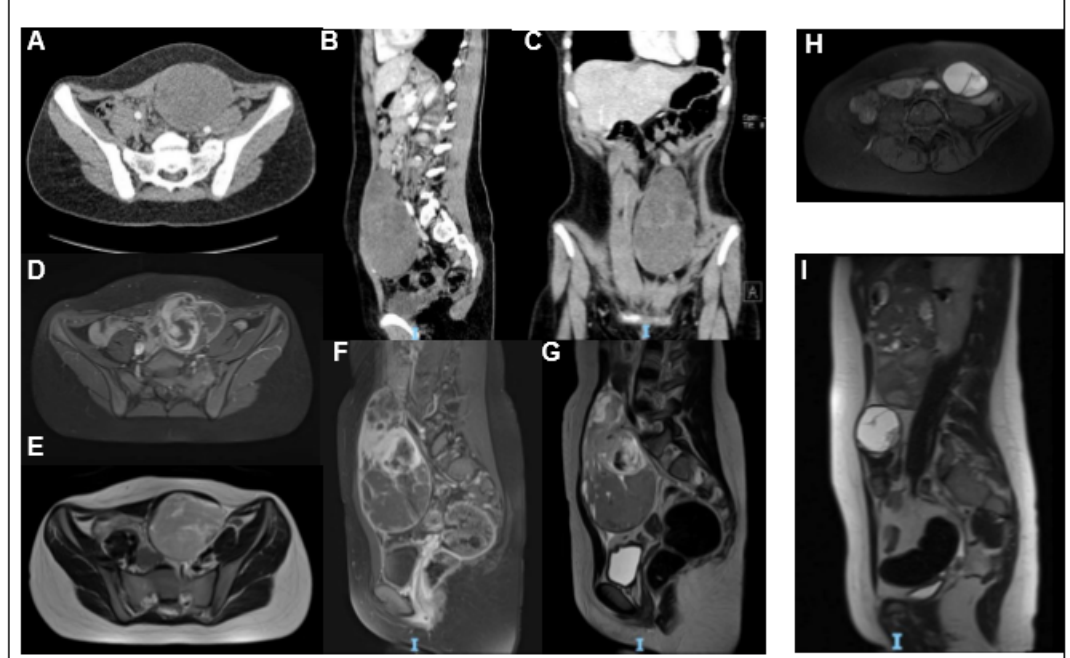
Figure 1. Imaging: Axial ( A ), sagittal ( B ), and coronal ( C ) Computed tomography (CT) scan images showing a gross expansive non-infiltrating mass, with clear and well-defined margins and an oval and oblong appearance. In coronal sections, it clearly shows a bilobated aspect with a homogeneously hypodense apical portion and a well-capped lower portion, which has a more uneven density, as in fluid internal lacunae. The lesion has a maximum size of 81.9 mm × 77 mm and a deep cranium-caudal extension of approximately 14 cm, up to the pelvic floor and posterior to the lumbosacral spine, which appears to have a cleavage plane. Magnetic resonance imaging (MRI) images ( D – I ) of the expansive process at diagnosis ( D – G ) and after neoadjuvant chemotherapy ( H – I ). T1w-fat sat axial ( D ) and sagittal ( F ), T2w axial (E ) and sagittal ( G ) images show a heterogeneous mass extending in the left abdominal wall, in the left paramedian seat at the level of the navel. T1w-fat sat axial images ( H ) and T2w sagittal ( I ) images show a clear reduction in the dimensions of the known expansive formation after chemotherapy.